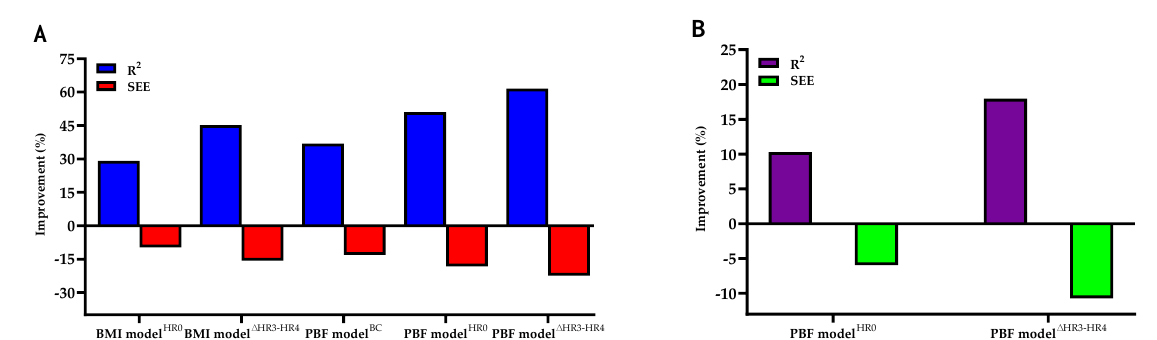
Figure 1. ( A ) Percentage improvement in VO 2max prediction accuracy in the BMI model HR0 , BMI model ∆ HR3 − HR4 , PBF model BC , PBF model HR0 , and PBF model ∆ HR3 − HR4 as compared with the BMI model BC . ( B ) Percentage improvement of VO 2max prediction accuracy in PBF model HR0 and PBF model ∆ HR3 − HR4 as compared with the PBF model BC . Figure 2 explains the correlation between the measured VO 2max and estimated VO 2max in the training group. There was no significant difference between the estimated VO 2max (PBF model BC : 34.96 ± 5.18 mL·kg − 1 ·min − 1 ; BMI model BC : 34.96 ± 4.42 mL·kg − 1 ·min − 1 ; PBF model HR0 : 34.96 ± 5.43 mL·kg − 1 ·min − 1 ; BMI model HR0 : 34.96 ± 5.02 mL·kg − 1 ·min − 1 ; PBF model ∆ HR3 − HR4 : 34.96 ± 5.62 mL · kg − 1 · min − 1 ; BMI model : 34.96 ± 5.33 mL · kg − 1 · min − 1 ) and the measured VO 2max (34.96 ± 7.01 mL · kg − 1 · min − 1 ).